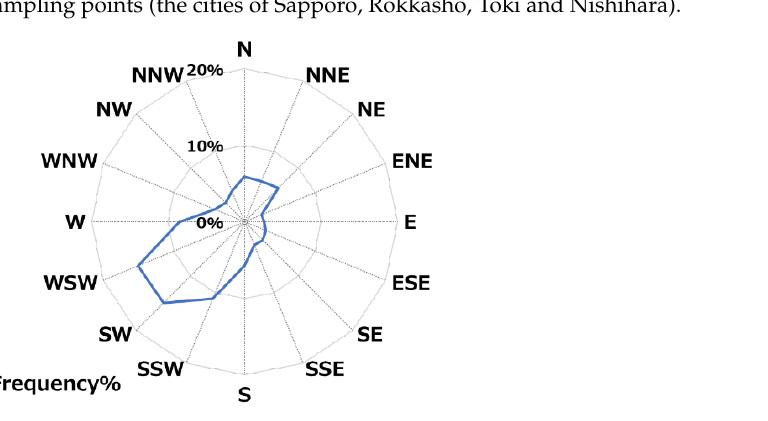
Figure 2. Frequency of the wind directions measured at Hirosaki City (2018 to 2020).